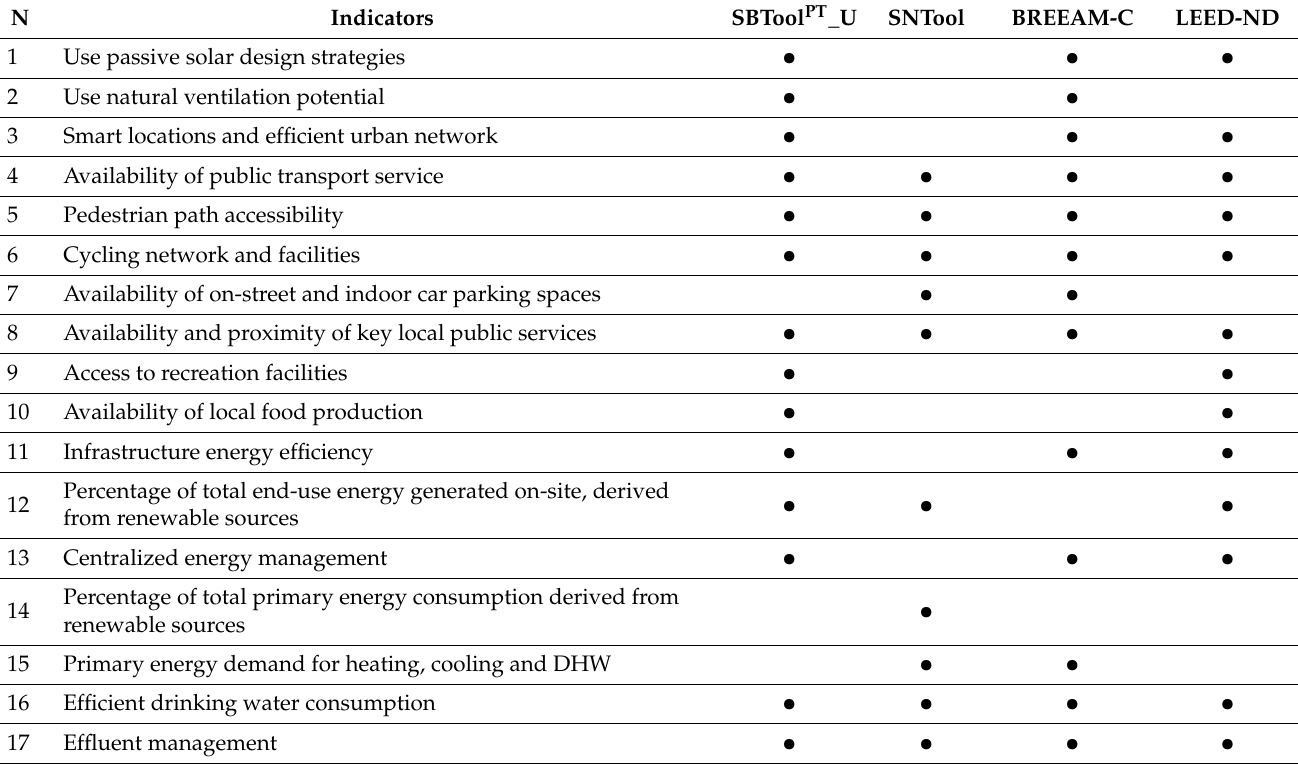
Table 2. Indicators with similar issues and objectives in SBTool PT _Urban (2018), SNTool Min (2020), BREEAM-C (2012), LEED-ND